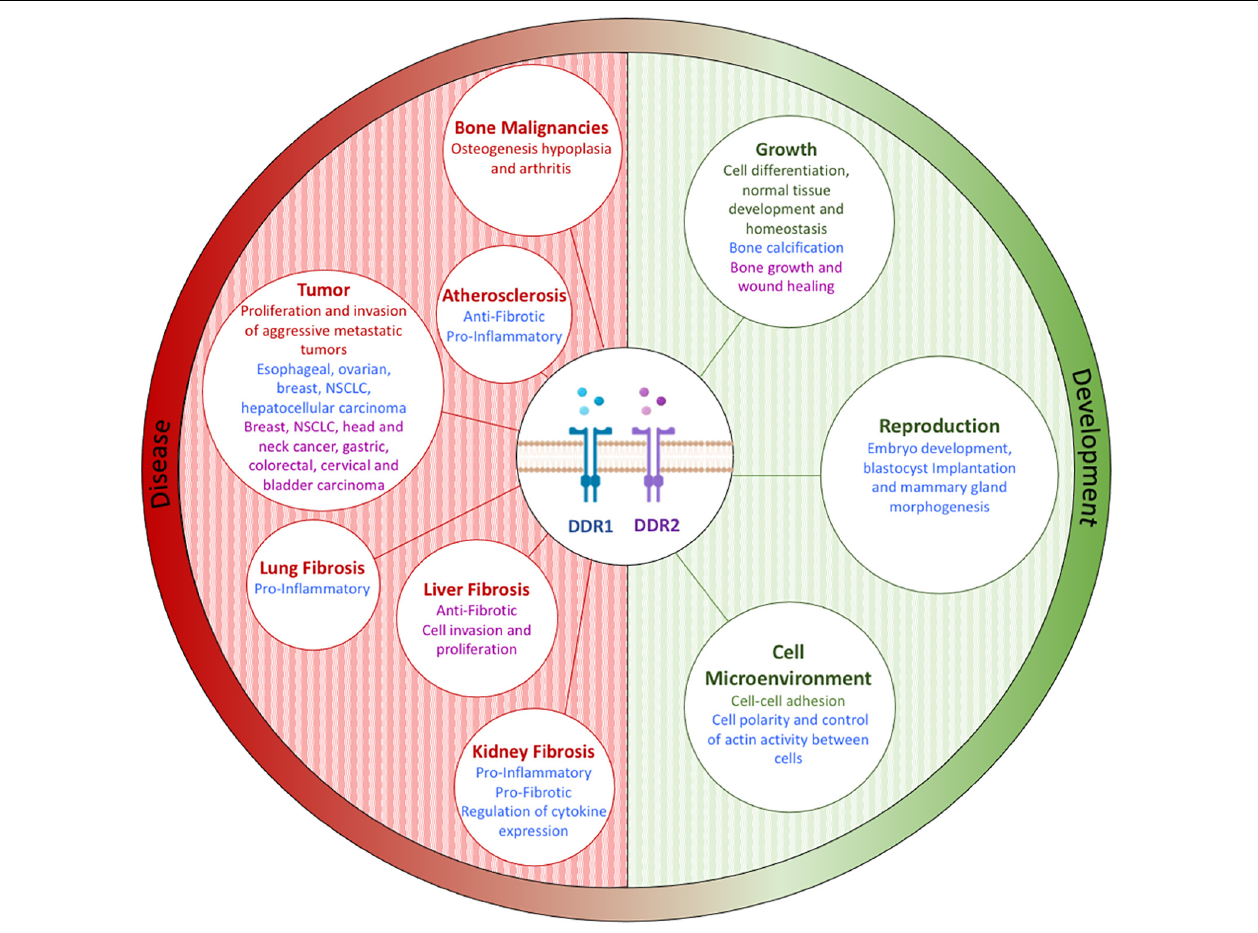
FIGURE 8 | Discoidin domain receptor tyrosine kinase expression and/or activation plays a role in both physiological (e.g., development) and pathological (e.g., cancer, inflammation, and fibrosis) conditions by controlling key cellular processes, including protease production, cytokine secretion, cell migration, immune cell recruitment, and matrix production. Figure adapted and modified from Borza and Pozzi